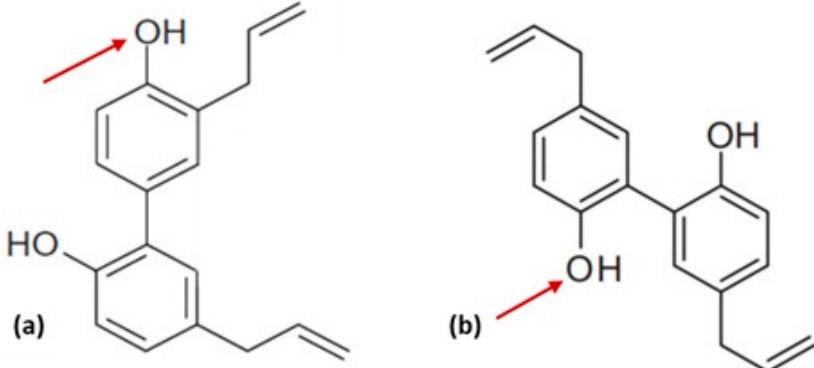
Figure 1. ( a ): The structure of honokiol [24]; ( b ): The structure of magnolol [25]. Arrow indicates the difference in the position of hydroxyl group between honokiol and magnolol.